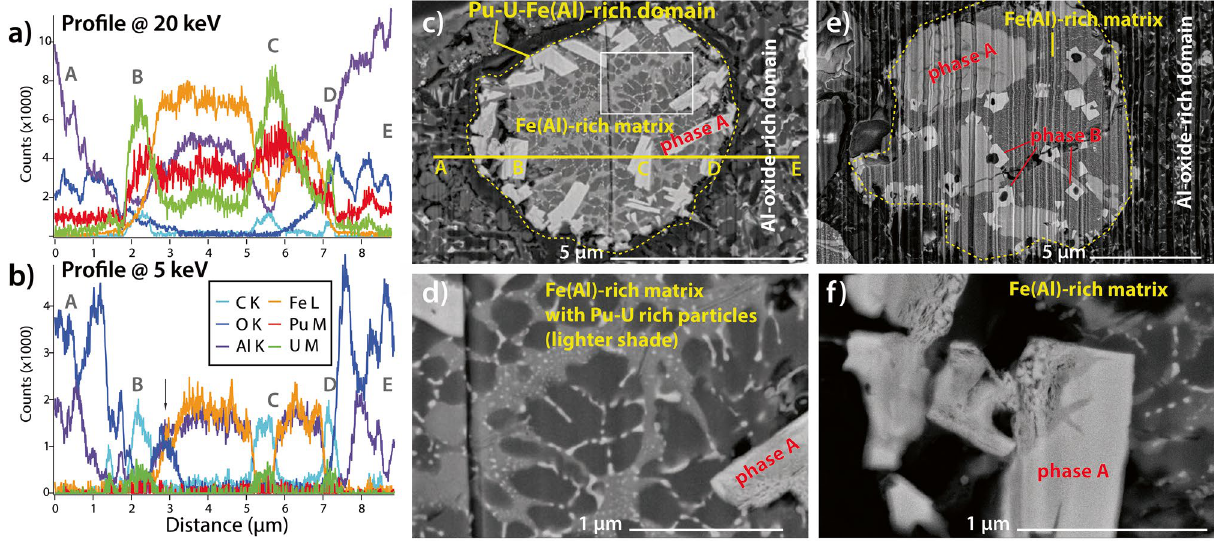
Figure 4. Details of the composition of Bruce . ( a , b ) FIB-SEM EDX line scans across the Pu–U-Fe(Al)-rich spheroid shown in ( c ); both profiles were measured at the same location, but at 20 and 5 kV respectively. These line scans demonstrate that the outer phase (labelled Al-oxide-rich matrix) consists predominantly of Al-O, and contains low levels of Pu–U, both in the background (site labelled ‘A’) and in particulate form (‘E’). The large, light grey, lath-shaped phase A grains (sites ‘B’, ‘C’, ‘D’) are Pu–U–C with minor Fe–Al. The matrix within the spherical area contains variable amounts of Fe–Al: the lighter areas contain more Fe than Al, i.e. between B and C, compared to the darker area that contains more Al than Fe, i.e. between C and D. This Fe(Al) alloy matrix also contains low levels of Pu–U. ( d ) Detail of ( c ); location in ( c ) is marked by a white rectangle. The Fe(Al) matrix of the this Pu–U–Fe(Al)-rich spheroid has broken down into an assemblage of two Fe(Al) alloys with different Fe:Al ratios (dark- and medium grey), and Pu–U rich nanoparticles (white). ( e ) Another Pu–U– Fe(Al)-rich sphere that contains phase A and B inclusions; note vapor bubbles associated with phase B. Vertical curtailing is an artifact of FIB polishing. ( f ) A detail of phase A, showing local compositional variation and